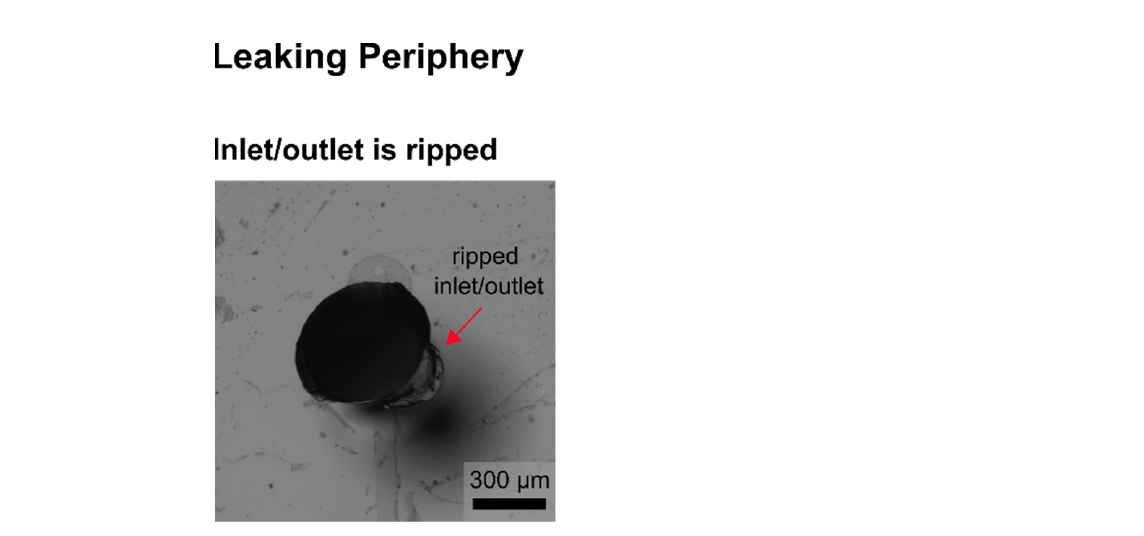
Figure A2. Example images of inefficient chip loading (see Table 3). Microscope images of too many cells enter chamber during loading.